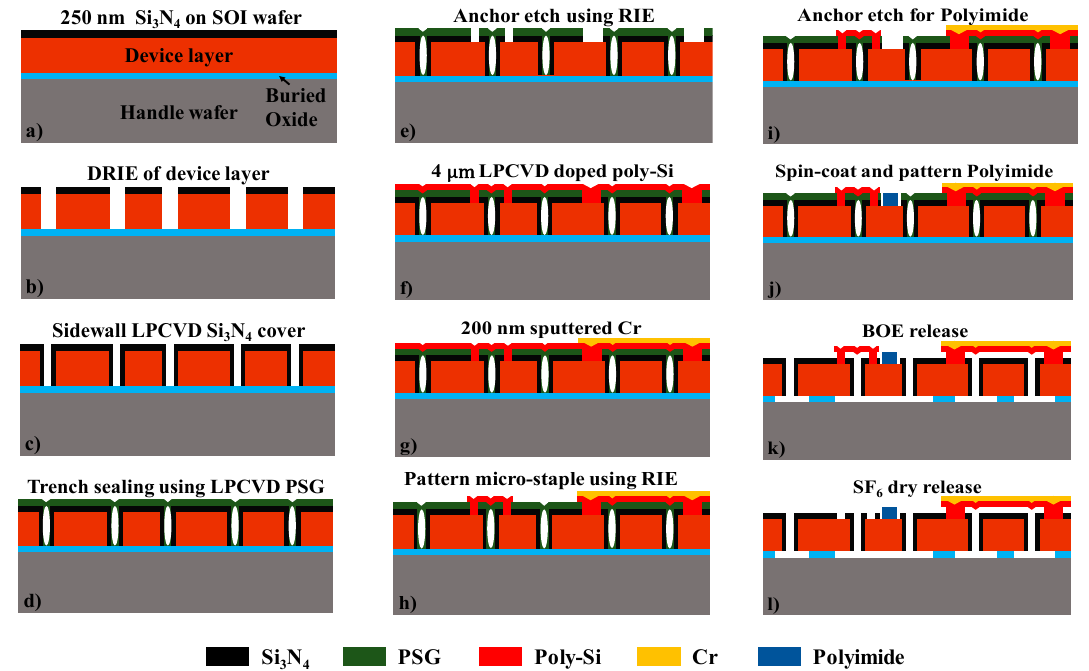
Figure 4. Simplified fabrication procedure of the device.